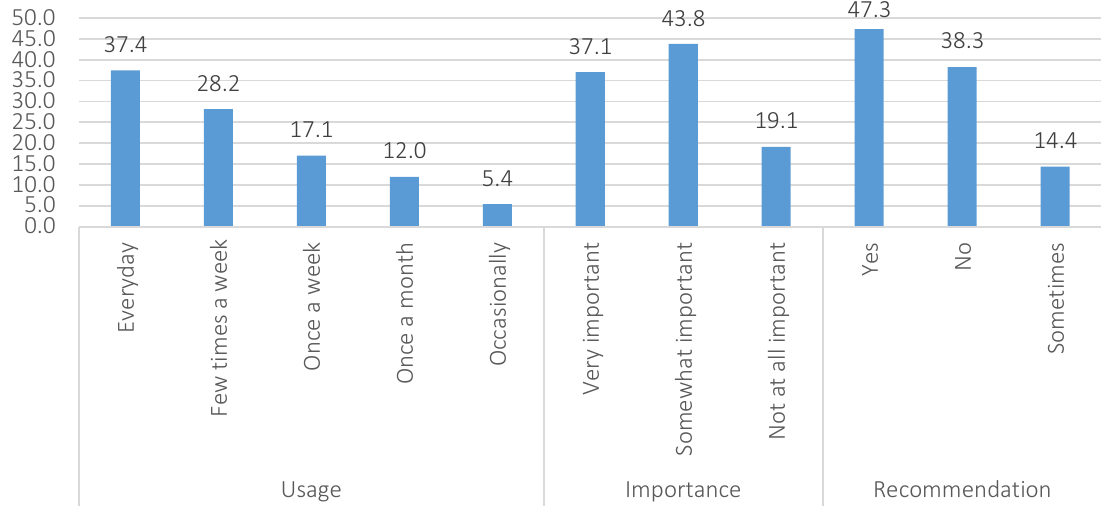
Figure 5. Background analysis on usage, importance, and recommendation